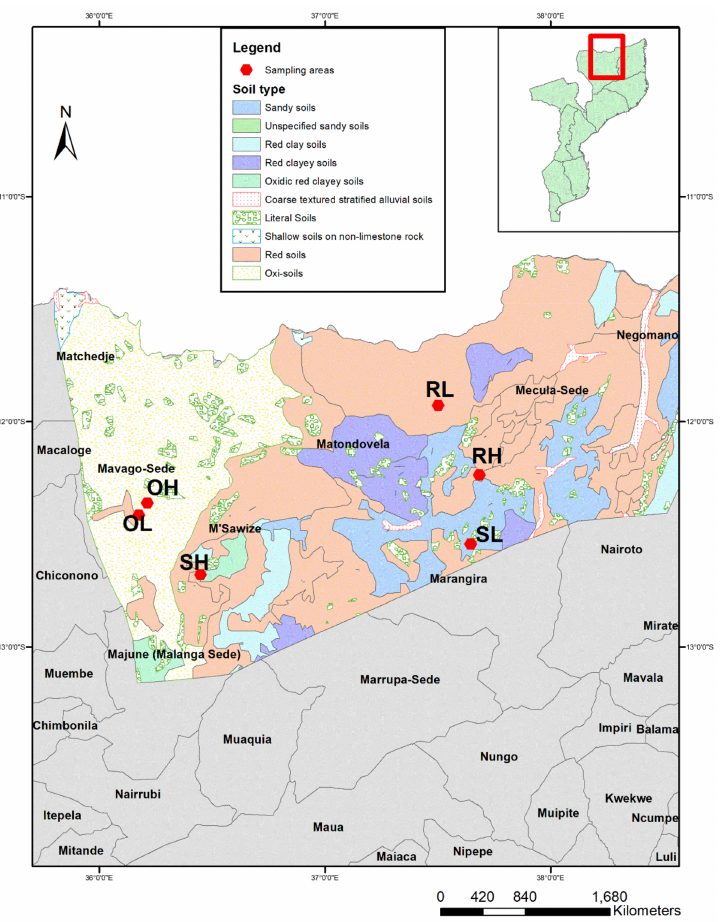
Figure 1. Geographic localization of the sampling sites (red dots) in the Niassa Special Reserve. Sampling points starting with S, R, and O indicate soil types of brownish-gray sandy soils, red soils of medium texture, and red oxi-soils of medium texture, respectively. Sampling points ending with H indicates high fire frequency (fire return interval < 1 year) while L (fire return interval > 7 years) indicates low fire